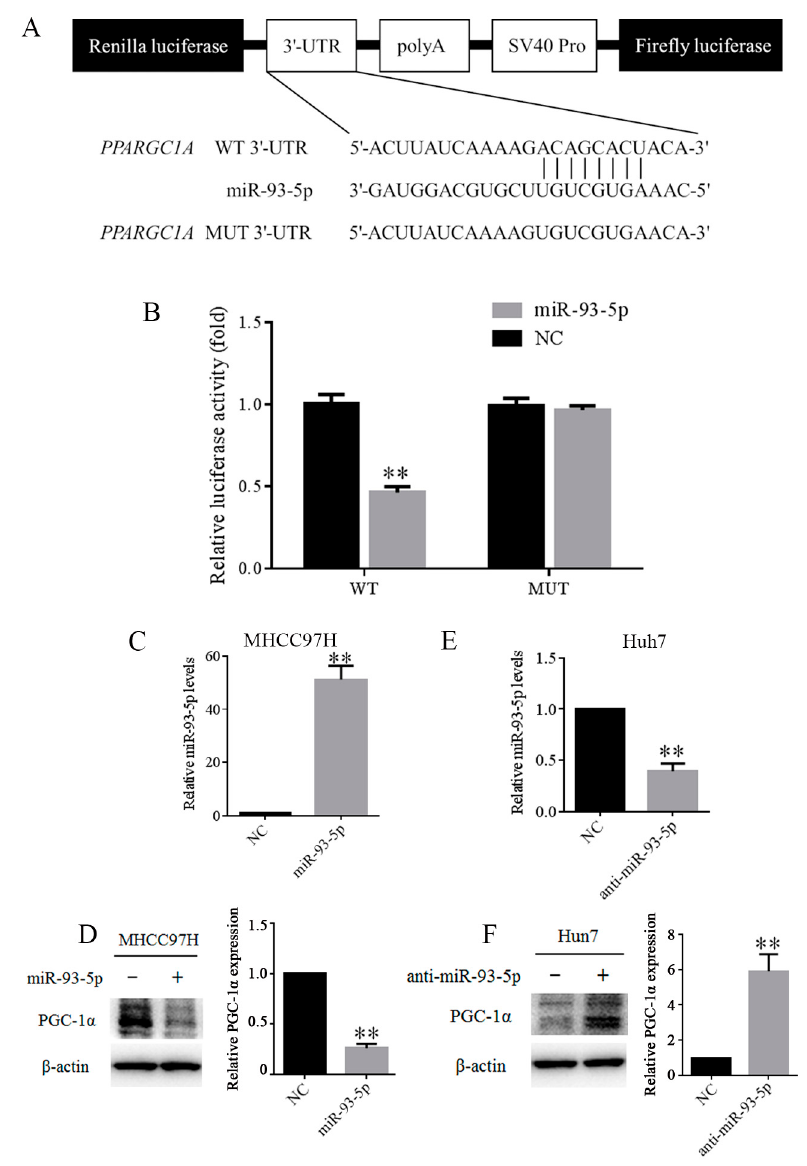
Figure 4. MiR-93-5p suppressed PPARGC1A expression by directly binding to its 3 ′ UTR. ( A ) Schematic representation of pairing of miR-93-5p with PPARGC1A wild-type (WT) and mutant (MUT) 3 ′ UTR luciferase reporter plasmids; ( B ) Relative luciferase activity in 293T cells co-transfected with WT or MUT 3 ′ UTR PPARGC1A reporter plasmids and miR-93-5p or NC; ( C , D ) MHCC97H cells were transfected with miR-93-5p mimic and NC mimic for 48 h. MiR-93-5p levels were detected by qPCR and PPARGC1A protein levels were detected by western blot; ( E , F ) Huh7 cells were transfected with anti-miR-93-5p mimic and NC mimic for 48 h. MiR-93-5p levels were detected by qPCR and PPARGC1A protein levels were detected by western blot. * p < 0.05, ** p < 0.01. UTR: Untranslated region; NC: Negative control